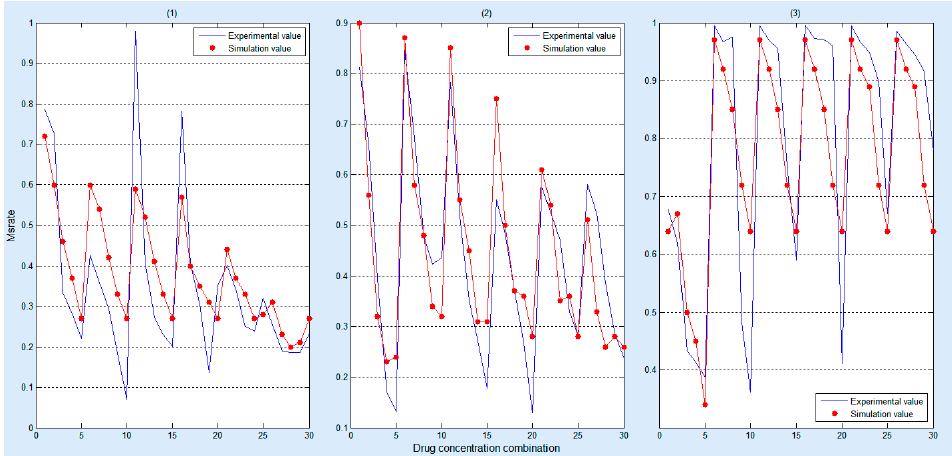
Figure 5. Comparison between simulation and experimental results under the impact of the ( 1 ) gefitinib and rosiglitazone; ( 2 ) erlotinib and imatinib; ( 3 ) gefitinib and quinacrine. The red dots represent the simulation result, and the blue polylines represent the biological experimental data, wherein, 0 to 30 on the X axis represent a drug concentration combination detailed in Supplementary Table 1, Supplementary Table 2 or Supplementary Table 3, respectively.